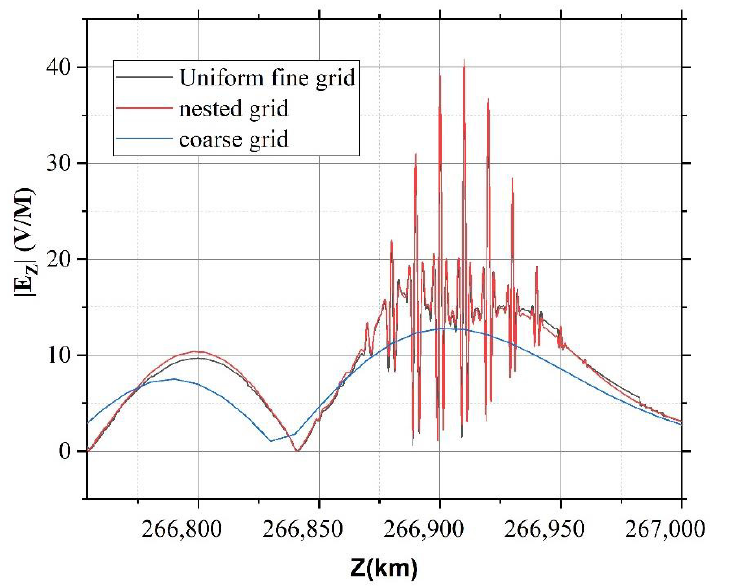
Figure 6. Vertical electric field | E z | in the altitude range of 266.85–267 km at 1.5194 ms with different resolutions.